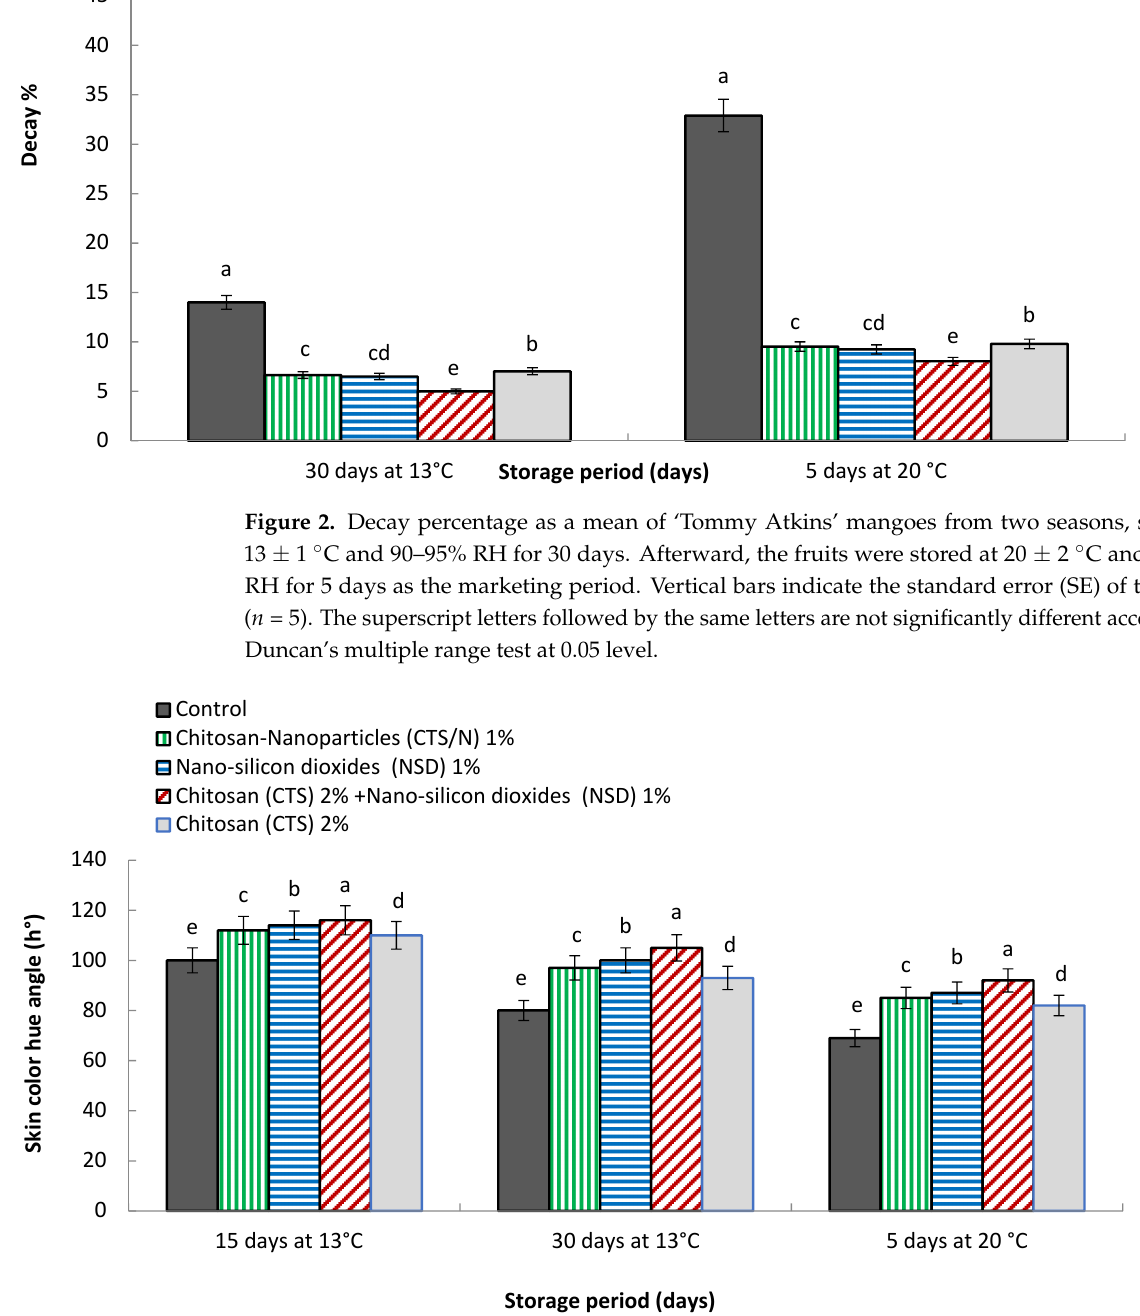
Figure 3. Skin color hue angle (h ◦ ) as a mean of ‘Tommy Atkins’ mangoes from two seasons, stored at 13 ± 1 ◦ C and 90–95% RH for 30 days. Afterward, the fruits were stored at 20 ± 2 ◦ C and 70–75% RH for 5 days as the marketing period. Vertical bars indicate the standard error (SE) of the mean ( n = 5). The superscript letters followed by the same letters are not significantly different according to Duncan’s multiple range test at 0.05 level.